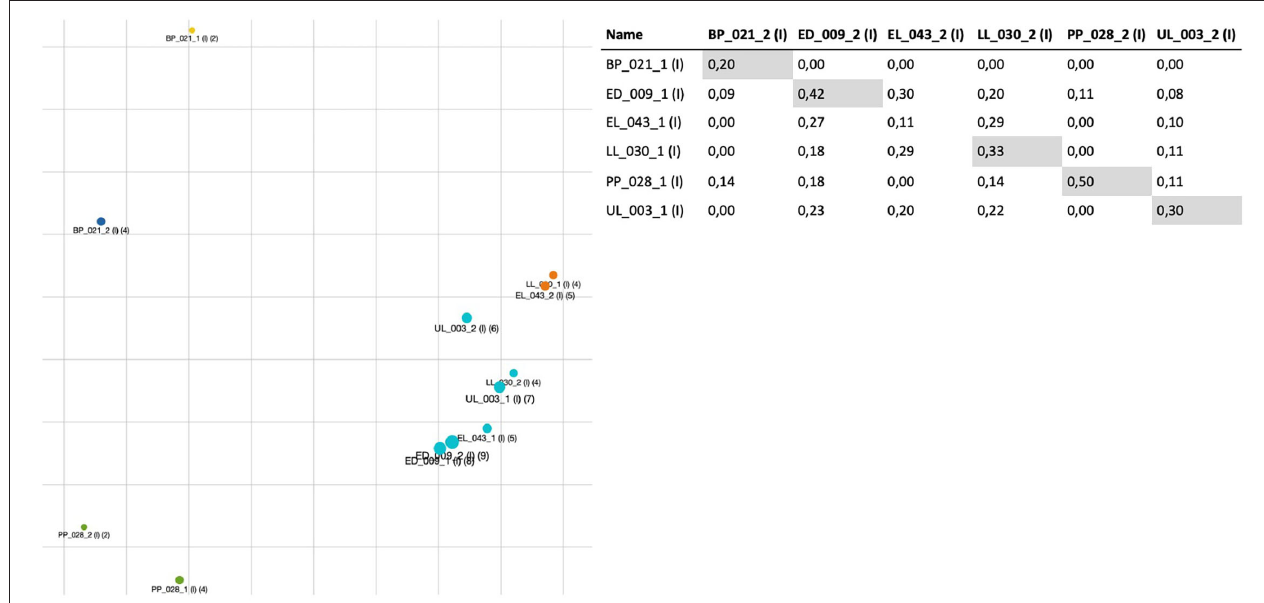
FIGURE 4 | (Left): Similarity map based on Jaccard’s Coefficient for all non-leaders in the emoji condition. The distance between the individuals’ text excerpts reflects the respective degrees of similarity. (Right): The closer the result is to 1, the more similar the parts of the chats are to each other. Gray indicates “correct” attributions.